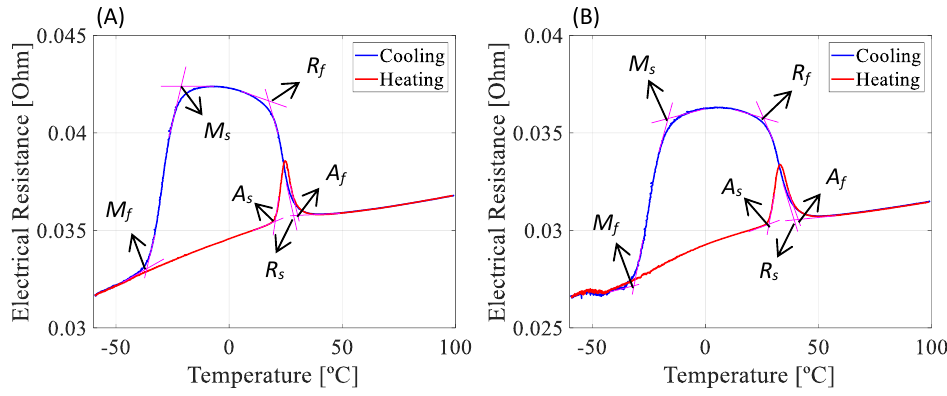
Figure 11. Electrical resistance as a function of the temperature. ( A ) NiTi strip and ( B ) M-Shape device of NiTi. Table 3. Temperatures of phase transformation of the SMA-SE.